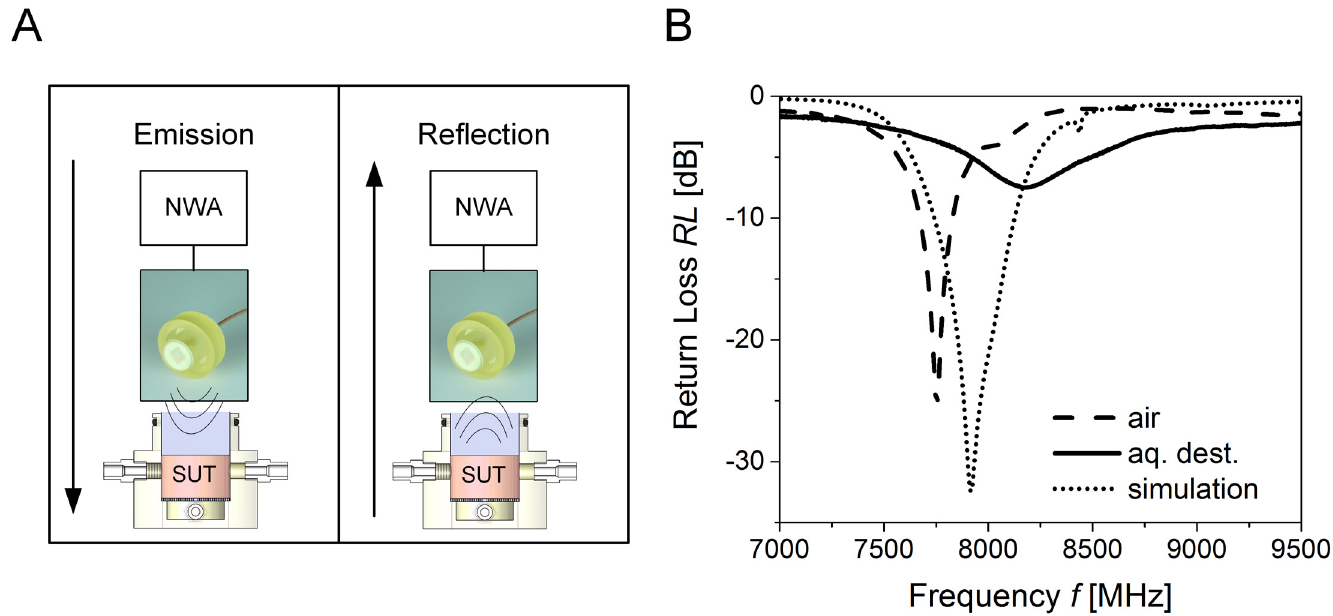
Fig 1. Microwave reflection measurement. (A) A patch antenna, optimized at f = 7.9 GHz, was connected to a network analyzer (NWA) and microwaves were introduced to a substance under test (SUT). Following microwave emission, the reflected signal was detected. (B) Each SUT exhibited a specific return loss ( RL ) and frequency at the local minimum ( f min ), exemplarily shown for purified water (aq. dest.) and air. Measurements were compared to a mathematical electromagnetic antenna model. The reflection minimum and frequency for air shifted in a range between 7000 – 9000 MHz for simulation and measurements.